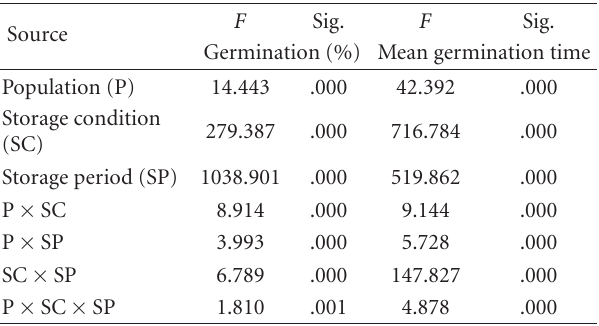
Table 2: Result of multivariate ANOVA, showing the e ff ect of populations, storage conditions, and storage periods and their interaction on seed germination and mean germination time in Swertia chirayita (using General Linear Model in SPSS 10.0 for windows; SPSS Inc.